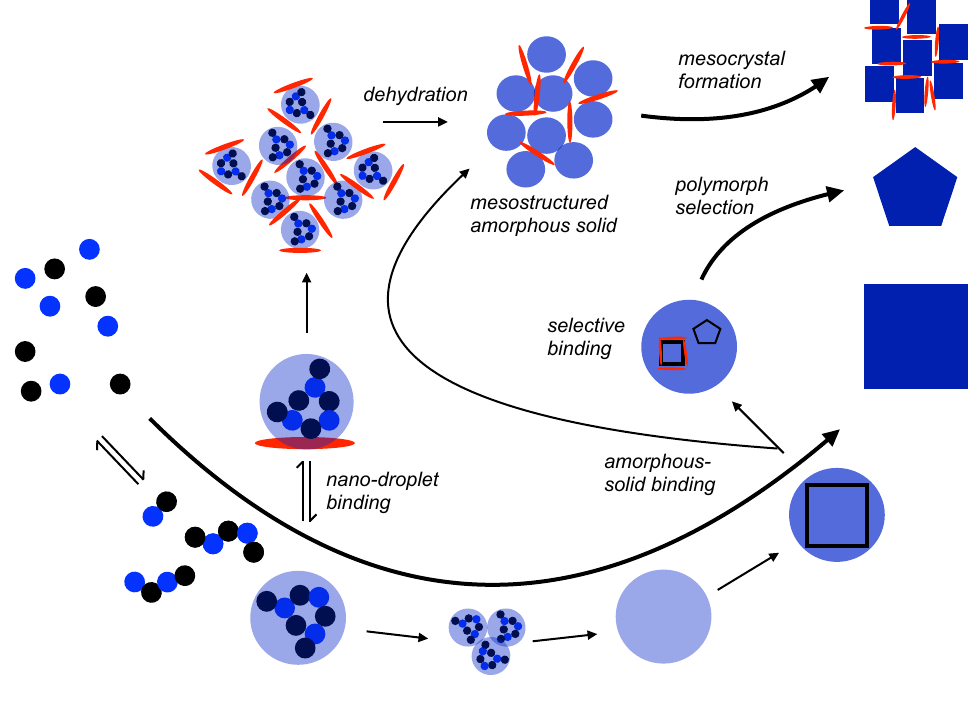
Figure 4. Schematic illustration of the mechanism of nucleation according to the PNC pathway (bottom, also cf. Figure 1) with potential effects of nano-droplet and amorphous-solid adsorption by additives (red ellipsoid) that do not kinetically stabilise liquid intermediates, at least to any significant extent. For explanation see the